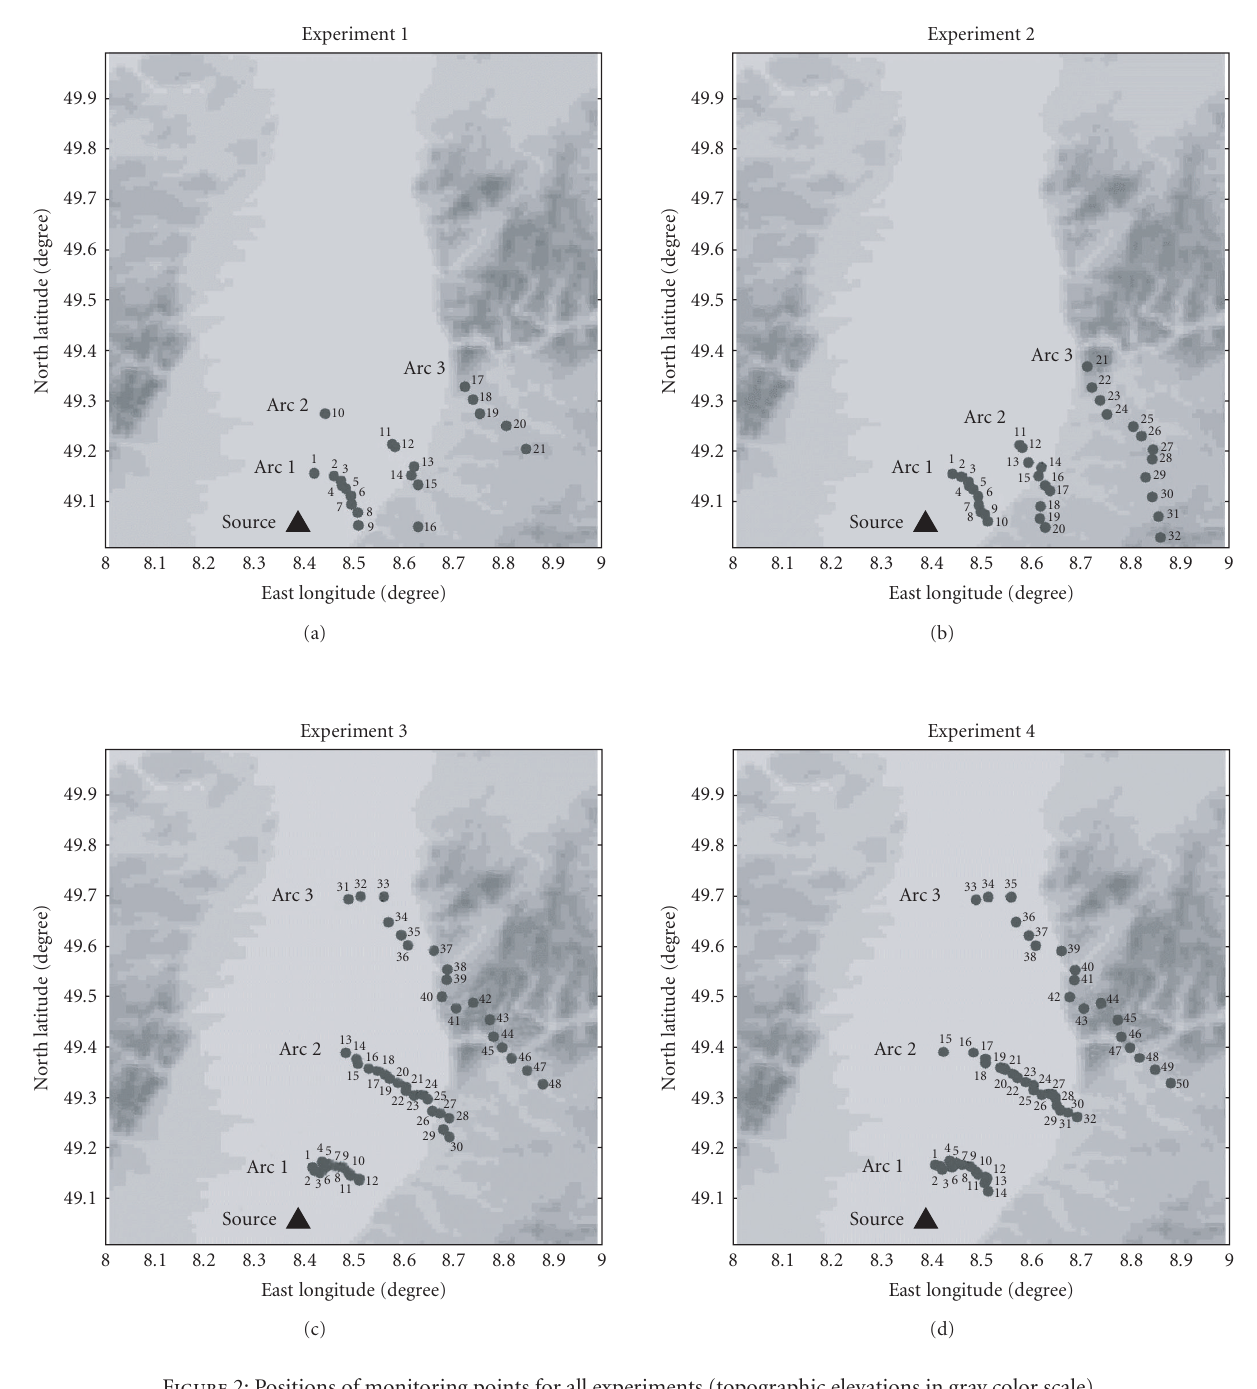
Figure 2: Positions of monitoring points for all experiments (topographic elevations in gray color scale).